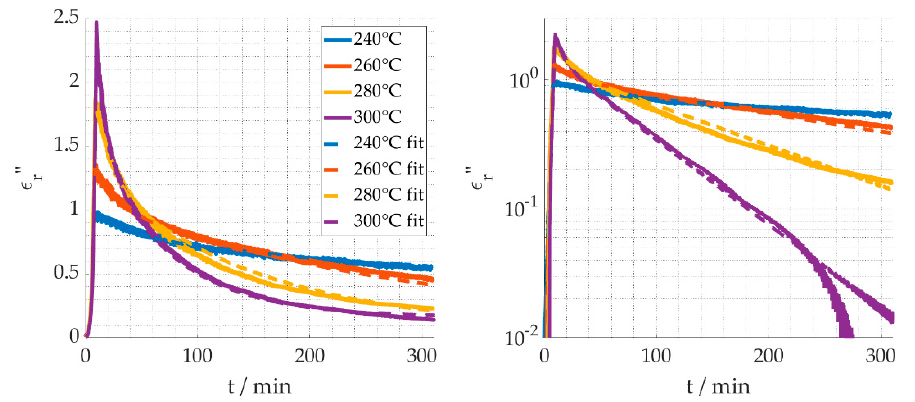
Figure 9. Linear ( left ) and logarithmic ( right ) graphical presentation of the measured dielectric loss and the fitted curves.